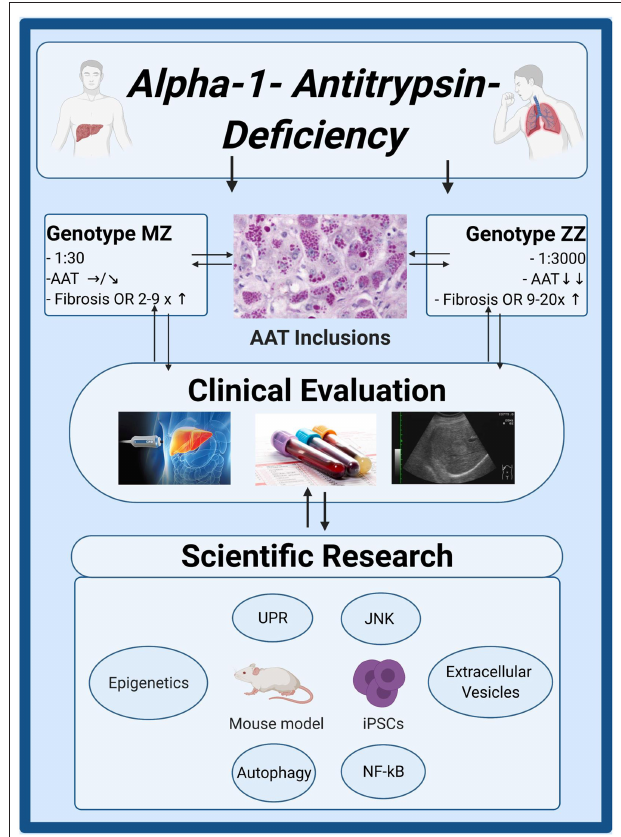
FIGURE 4 | Clinical and scientific insights in alpha1-antitrypsin deficiency. Genotype MZ/ZZ refers to a presence of a heterozygous/homozygous Pi*Z mutation in alpha1-antitrypsin (AAT) gene. The upper boxes describe the frequency of both genotypes in Caucasians, the resulting serum AAT levels and their risk to develop advanced liver fibrosis compared to individuals without AAT mutations. Non-invasive techniques such as liver stiffness measurement by transient elastography or determination of aspartate aminotransferase to platelet ratio index (APRI) are suitable to estimate the amount of histological liver fibrosis. Liver ultrasounds are recommended for individuals with advanced liver fibrosis as a method of HCC surveillance. Several molecular pathways (NF- κ B, JNK), protein degradation machineries (UPR, autophagy) as well as epigenetic modifications or appearance of extracellular vesicles with pro-fibrogenic cargo may contribute to disease developments. Created with BioRender.com. iPSCs, induced pluripotent stem cells; JNK, C-Jun